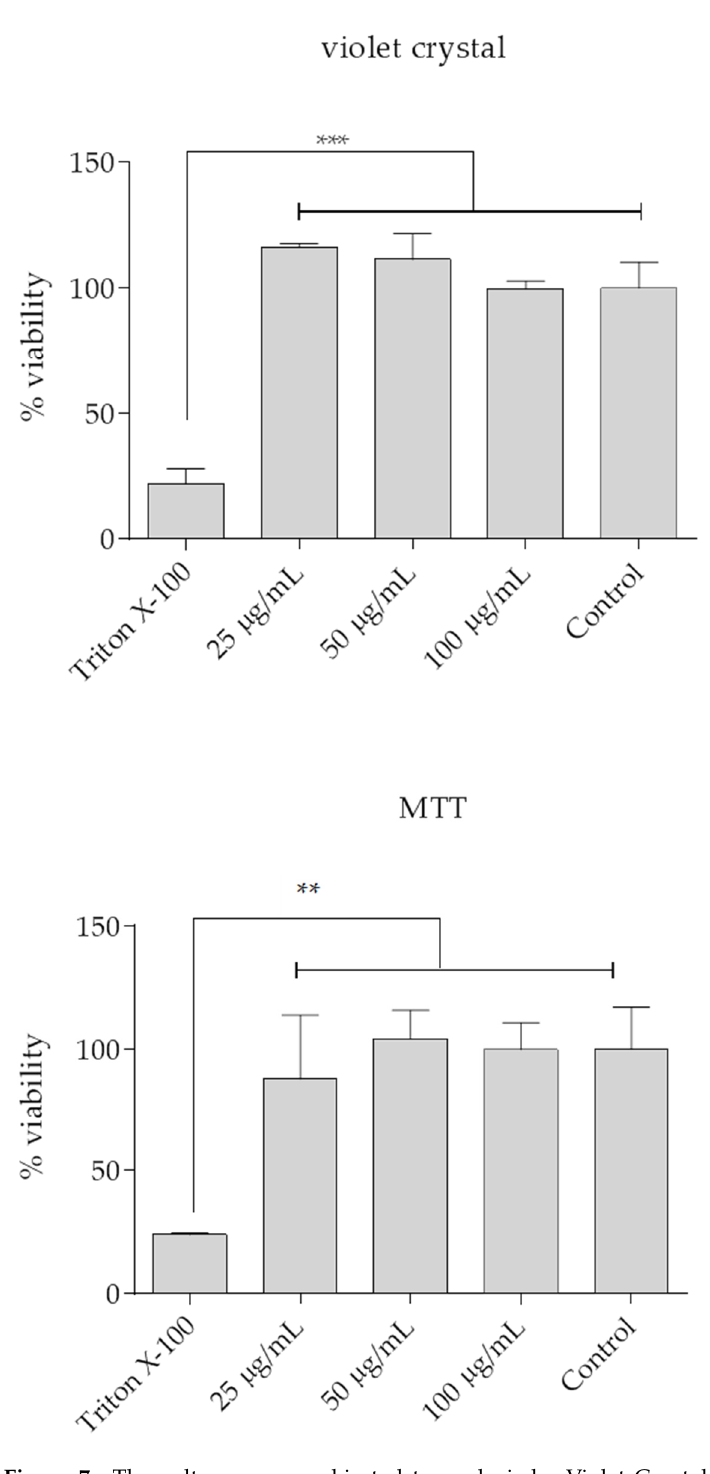
Figure 7. The cultures were subjected to analysis by Violet Crystal and MTT assays. In both assays, no significant differences were observed between the viability of cells treated with the three concentrations of rHlyA and the positive control p > 0.05. Cell viability was significantly reduced only in the negative control (Triton X-100) when compared to the different groups. *** p ≤ 0.001 and ** p ≤ 0.01, Crystal Violet and MTT, respectively.